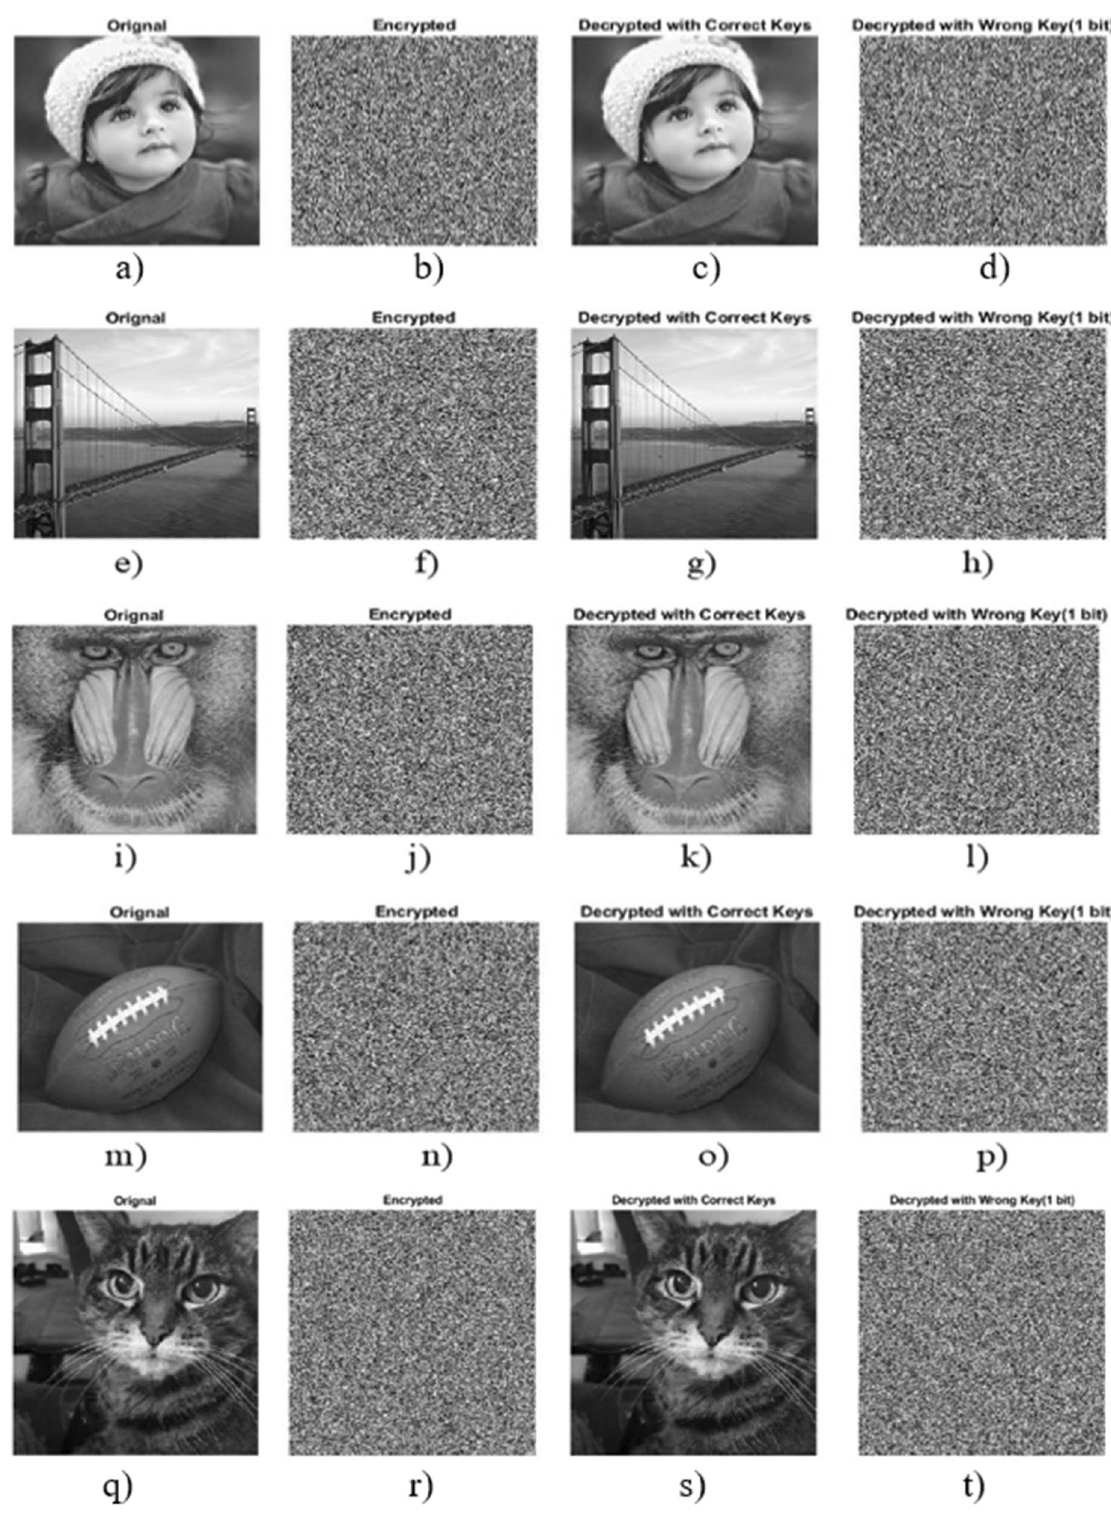
Fig. 12 Statistical analysis of key sensitivity by decrypting the same image with two keys: one is the actual key and another is a wrong key that differs by only a single bit from the actual